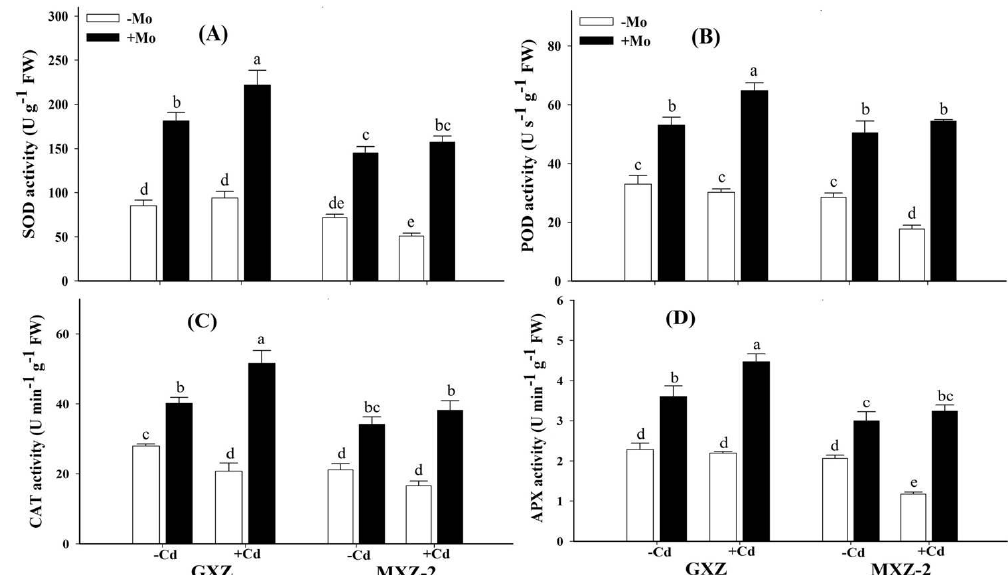
Figure 4. Influence of molybdenum (Mo) and cadmium (Cd) on enzymatic antioxidants; ( A ) superoxide dismutase (SOD), ( B ) peroxidase (POD), ( C ) catalase (CAT), and ( D ) ascorbate peroxidase (APX) activities in leaves of two fragrant rice Guixiangzhan (GXZ) and Meixiangzhan-2 (MXZ-2) cultivars. Both fragrant rice cultivars were treated with two molybdenum levels: 0 µM (–Mo) and 1 µM (+Mo), against two cadmium levels: 0 µM (-Cd) and 100 µM (+Cd) in modified Hoagland solution. Vertical bar above indicates standard error of four replicates. Different lowercase letters (a, b, c, etc.) represent significant differences according to the LSD-test ( p < 0.05, n = 4). Interestingly, Mo supplementation mitigated the Cd toxicity effects under combined (Mo+Cd+) treatment and significantly increased the SOD (136.25% and 209.01%), POD (114.65% and 206.69%), CAT (148.56% and 129.68%), and APX (103.41% and 176.55%) activities in GXZ and MXZ-2 rice